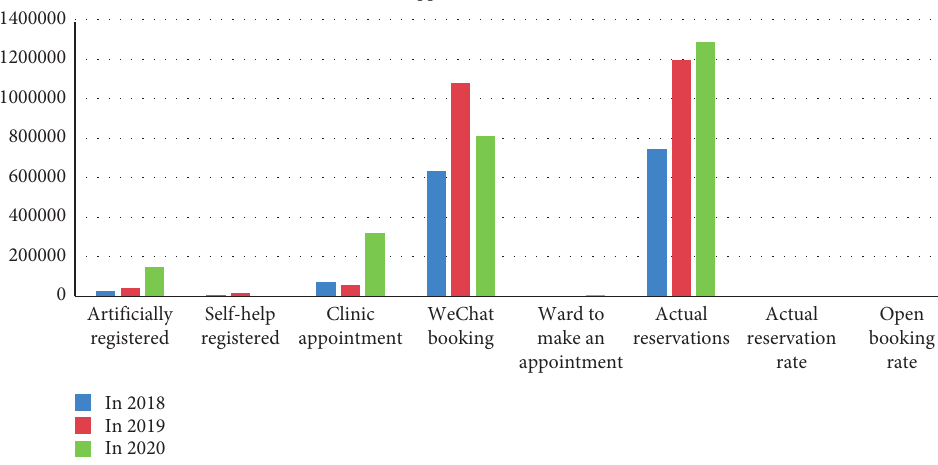
Figure 3: The workload of appointment medical services in